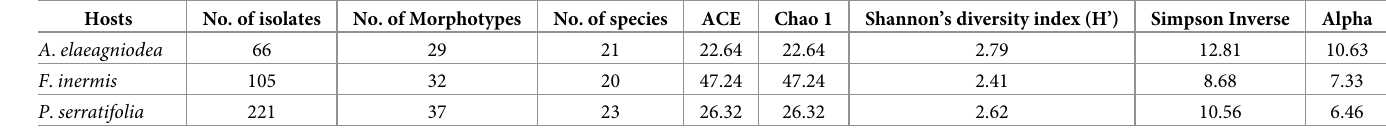
Table 2. Species richness (ACE and Chao 1), evenness (Simpson Inverse and Alpha) and Shannon’s diversity (H’) indices of A . elaeagniodea , F . inermis , and P . serratifolia .